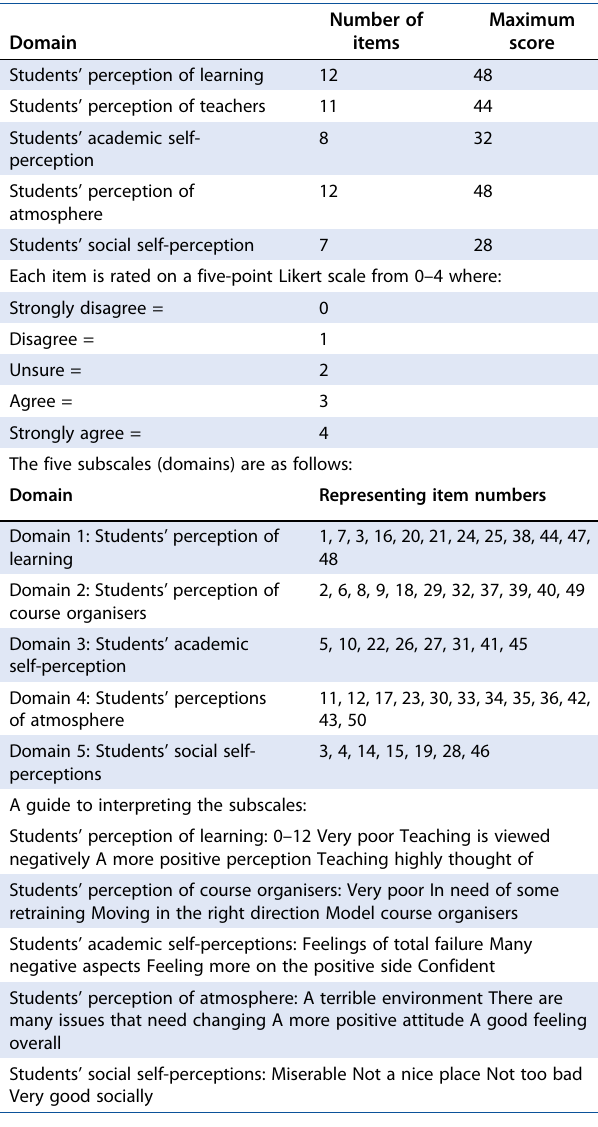
Table 1: The DREEM questionnaire domains Domain